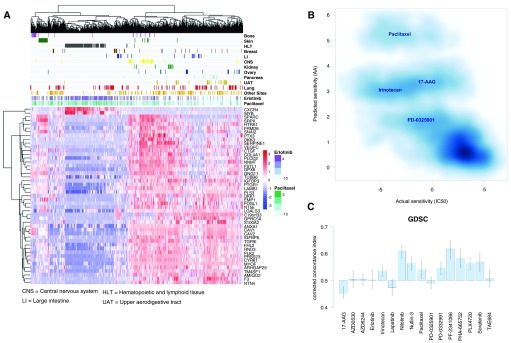
Different views of our model’s prediction capacity on the GDSC dataset.(
A) Cell line-drug experiments are visualized in terms of the 47-gene expression data. The panel above the gene expression heat map illustrates the natural logarithm of half-maximal inhibitory concentration LNIC50 (μM) values observed for selected sets of cancer cell lines (grouped by tissue site) and two compounds (erlotinib and paclitaxel). (
B) Application of CCLE-derived model to the GDSC data. Density plot of predicted (activity area (AA)) vs. actual sensitivity (LNIC50) values for drugs that are common between the CCLE and GDSC (n = 9,984). Pearson, Spearman and Kendall, correlations coefficients: -0.72, -0.71 and -0.50 respectively. (
C) Concordance indices between the predicted and the observed sensitivity values. An index value = 0.5 is the expected value from random prediction. Indices are corrected to account for the notion that higher concordance is reached when high AA (prediction) corresponds to a low LNIC50 (observed) values, and vice versa. Error bars: 95% confidence interval of the estimated concordance index.